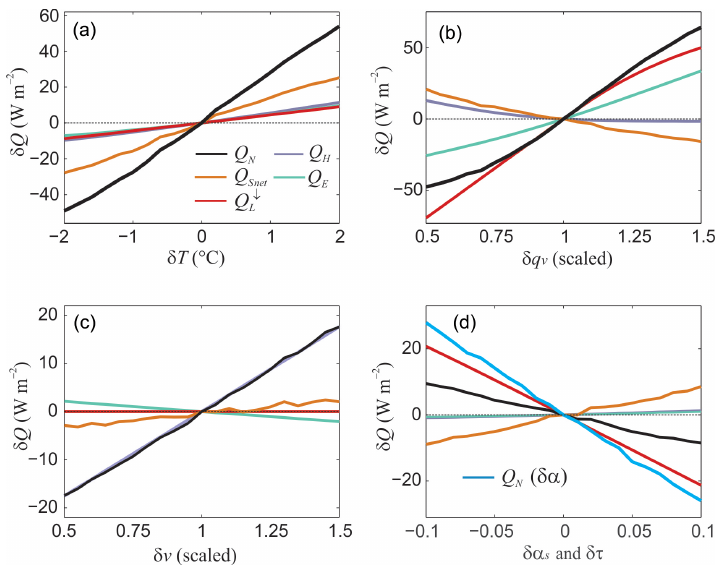
Figure 6. Sensitivity of the surface energy fluxes at Haig Glacier to changes in (a) temperature (case 2), (b) specific humidity (case 6), (c) wind speed (case 7), and (d) atmospheric transmittance (case 8) and albedo (blue line, case 9). All lines are anomalies relative to the baseline data from the period 2002–2012, and they indicate the mean sensitivity of the different energy fluxes over this period. Please note the different y(δQ)